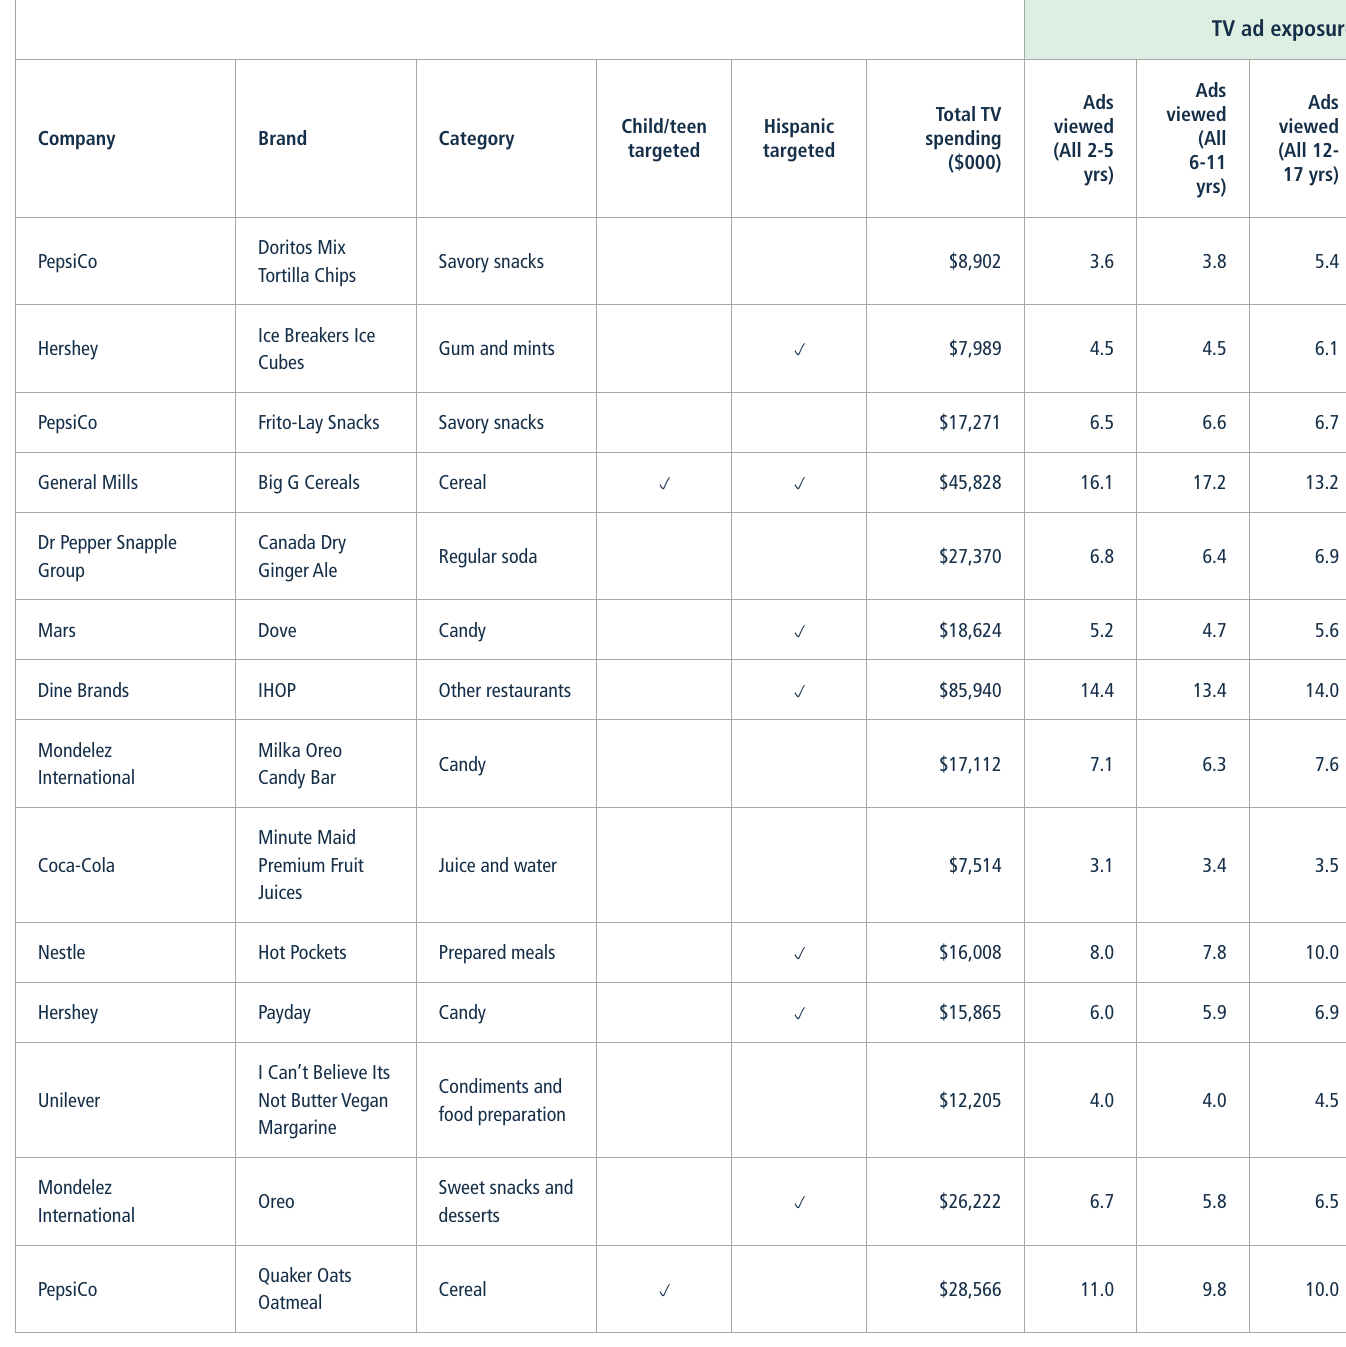
TABLE 3. BRANDS TARGETED TO BLACK CONSUMERS